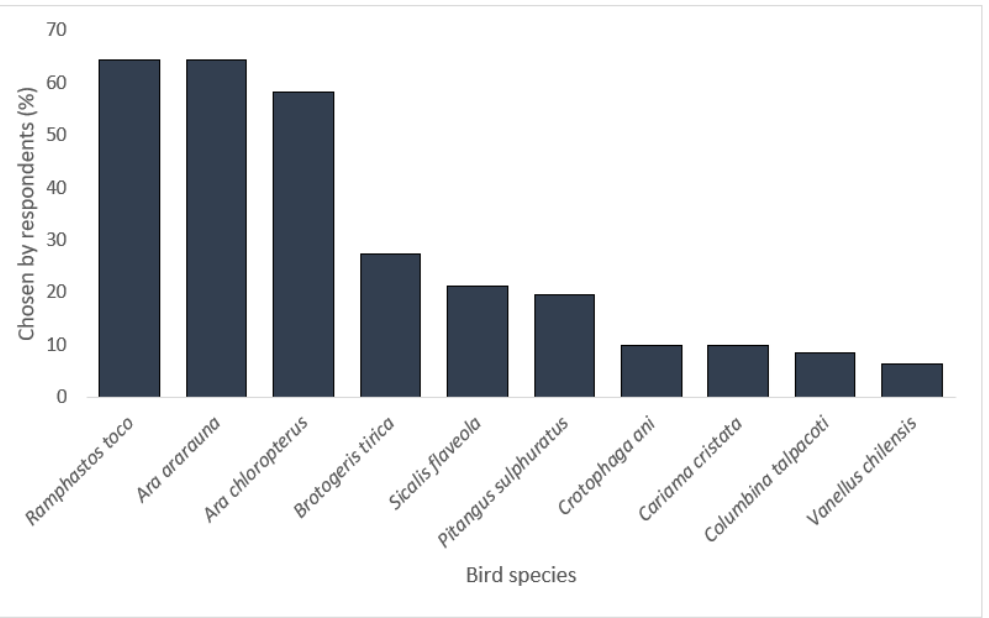
Figure 3. Percentage of individuals choosing each species as one of their three favorite birds in Rondonópolis.